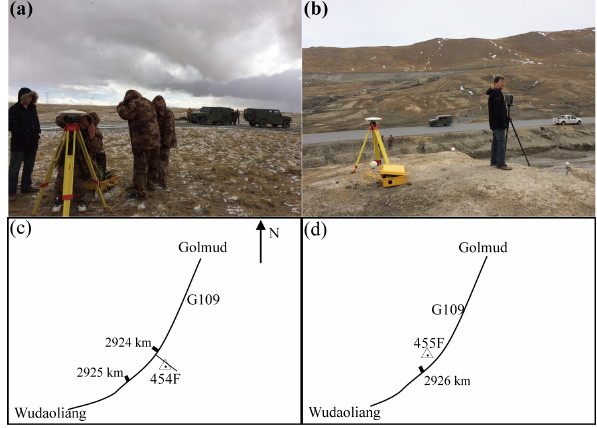
Figure 5. TLS observation with the GNSS from 2014 to 2015: (a) datum station of the GNSS, (b) TLS observation with the GNSS and white reference sphere set, (c) datum station 454F, and (d) da- tum station